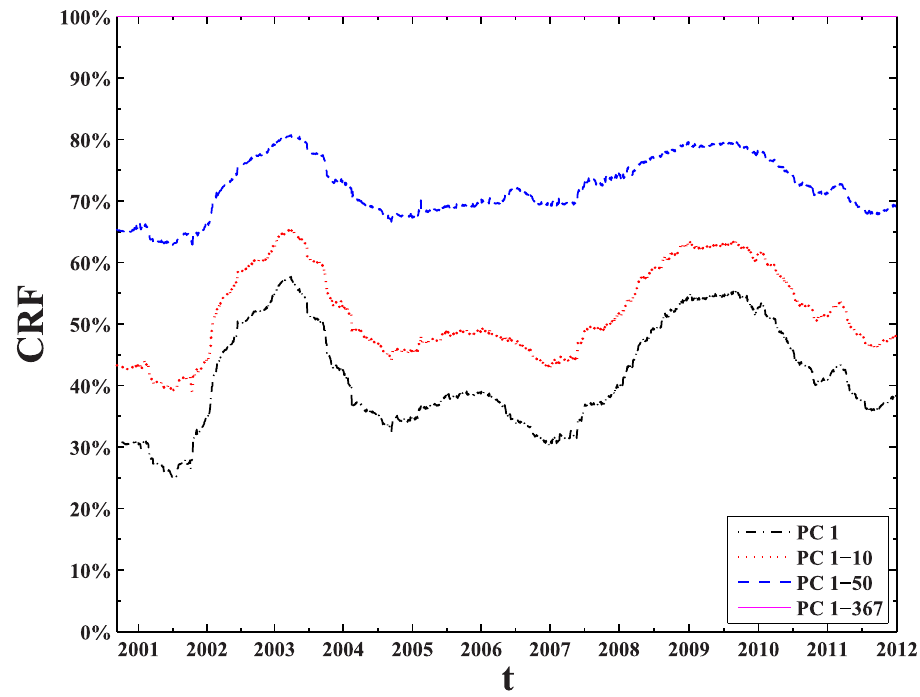
Figure 7. Dynamics of Cumulative Risk Fraction (CRF). CRF is measured by the eigenvalues obtained from the correlation matrix of the return series of 367 A-Share stocks within a moving window of length 400 days. Different lines correspond to the proportions of total variance explained by PC 1, PC 1-10, PC 1-50, and PC 1-367. PC 1 denotes the principal component corresponding to the largest eigenvalue l 1 .